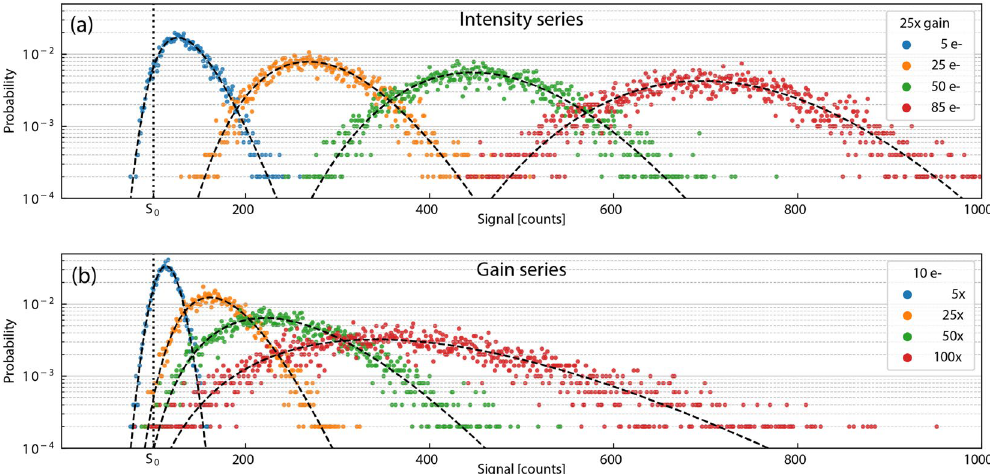
Figure 1. Series concept for parameter estimation. ( a ) An IS calibration collects samples from multiple intensity levels sharing a common gain value. Histograms of simulated samples at 25× gain (colored markers) and their corresponding PDFs (dashed lines) for four intensity levels are depicted. For larger photoelectron values, the Poisson distribution of the PGN model more closely resembles a normal distribution and the skewness, always positive for in the PGN model, decreases while the variance increases. ( b ) A GS calibration applies the same concept of grouping multiple measurements, but assumes independent gain parameters sharing a common photoelectron value. Depicted are the simulated histograms and PDFs for four gain levels representing a common intensity of 10 photoelectrons. For a constant intensity level, as gain increases, the skewness and variance both increase. The IS and GS depicted were simulations of 5000 samples, with σ 100 counts , and ADU 10 counts , S 0 3.5 e − / count , representing similar parameter spaces and sample = = = sizes as the cameras experimentally